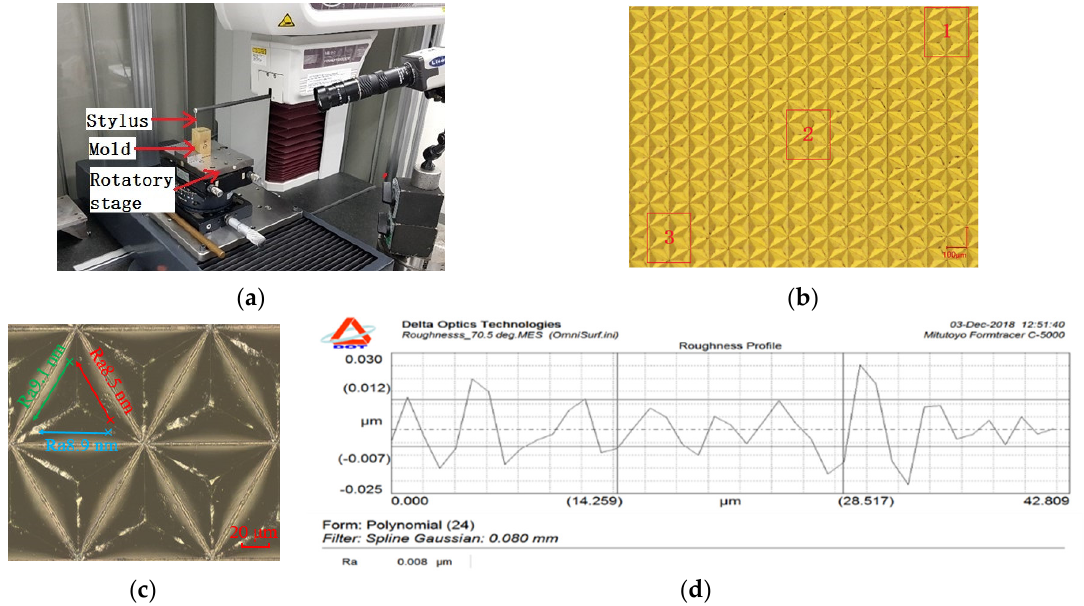
Figure 6. Surface roughness measured by a stylus profilometer: ( a ) Measuring conditions, ( b ) area of measurement, ( c ) measuring position, ( d ) roughness value. Table 3. Measurement of the triangular pyramid microstructure size and